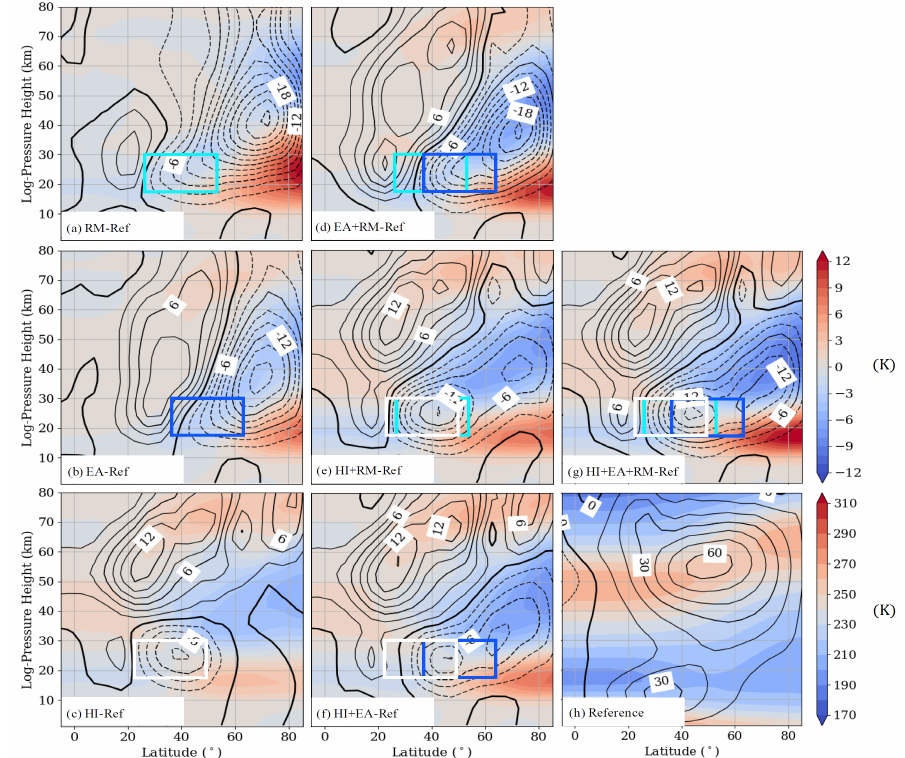
Figure A1. Zonal mean zonal wind differences (contour lines-in steps of 2ms − 1 ) and temperature differences (colored) between the single GW hotspots ( a )–( c ), the doubled GW hotspots ( d – f ) and the tripled GW hotspots ( g ) and the Ref simulation. ( a ) RM ( b ) EA ( c ) HI ( d ) RM + EA ( e ) RM + HI ( f ) HI + EA ( g ) RM + HI + EA. Temperature (color coding) and zonal wind (contour lines) of the Ref simulation are added in the lower right panel ( h ). The upper color bar refers to the temperature differences while the lower color bar refers to the temperature of the Ref